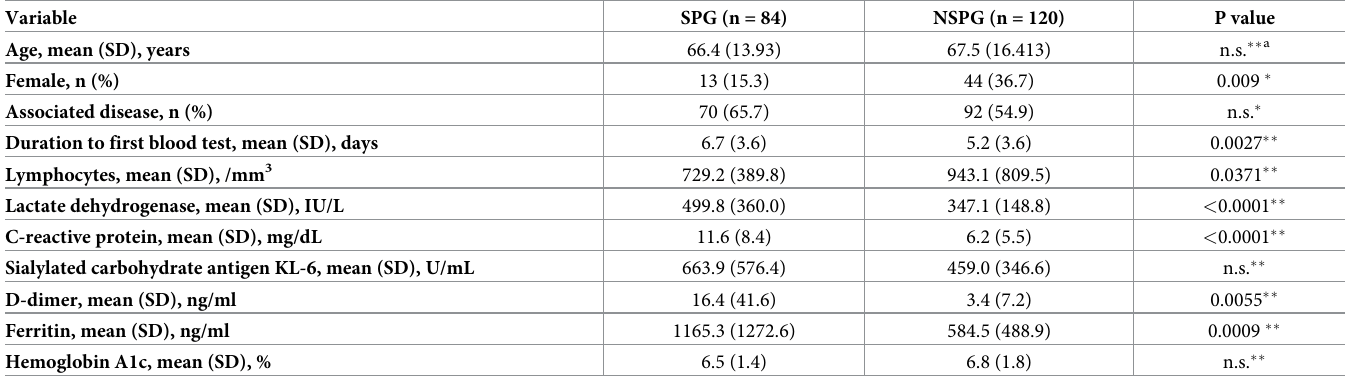
Table 2. Characteristics of patients (n =